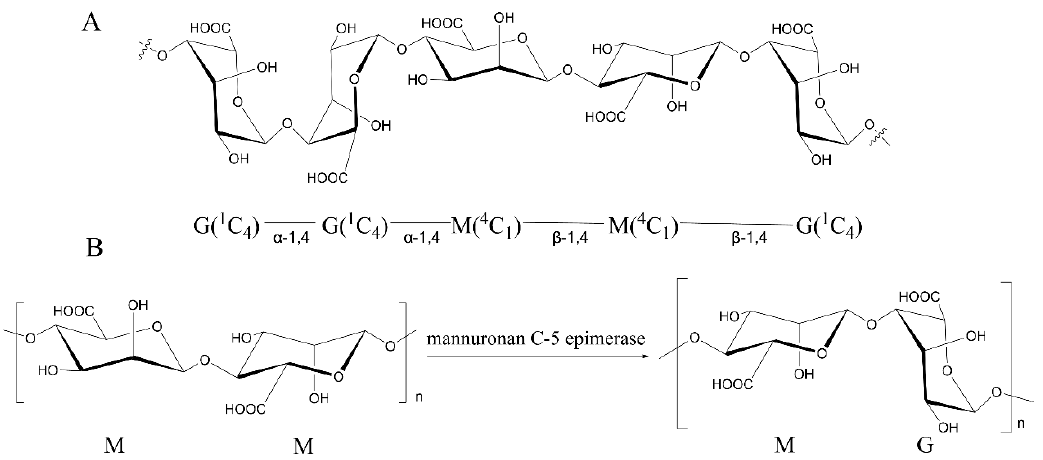
Figure 1. The structure of alginate and the function of ManC5-Es. ( A ) Chemical structure of the repeating units of alginate. ( B ) The conversion of the β -D-mannuronate (M) to α -L-glucuronate (G) residues by ManC5-Es [7].